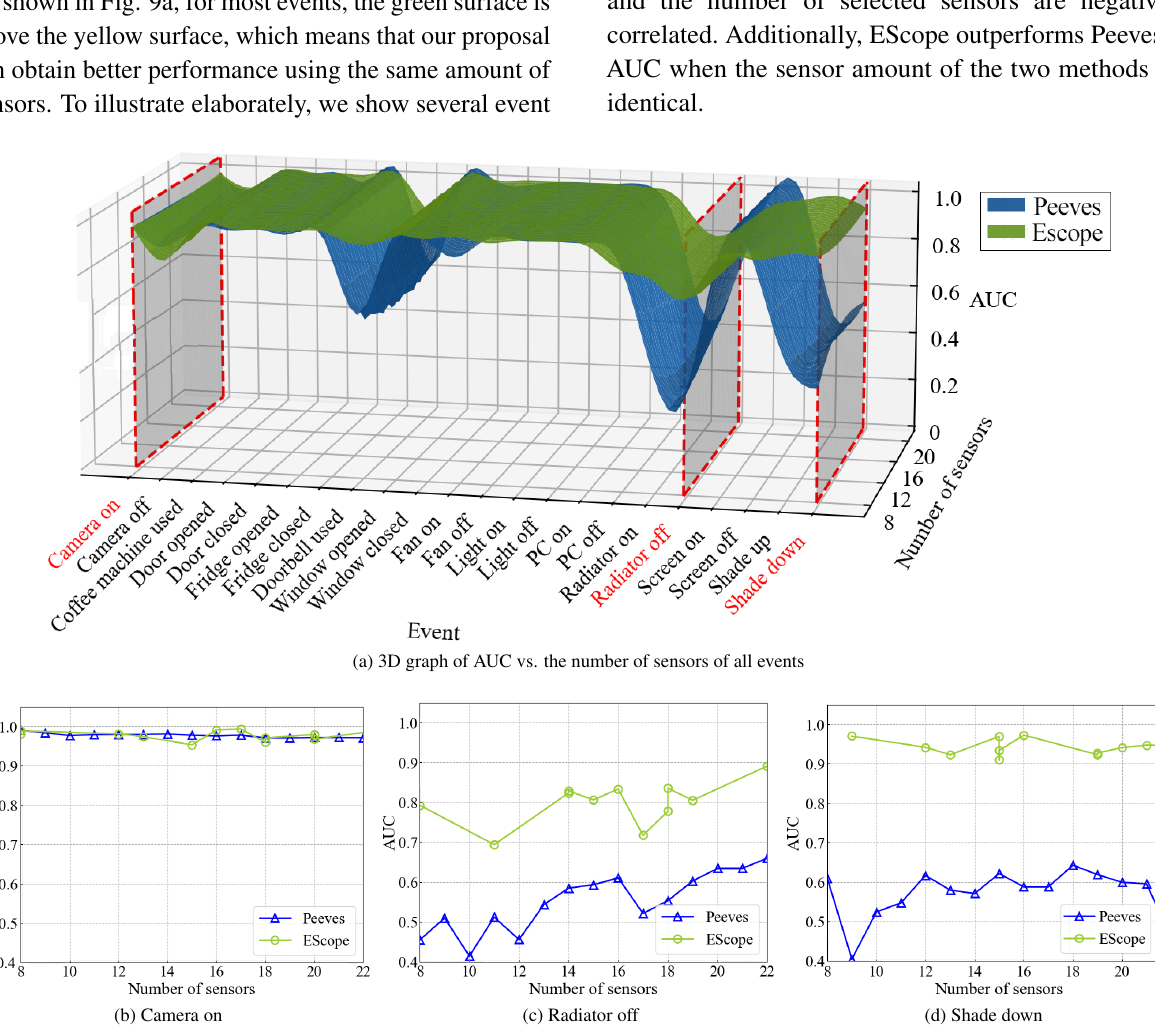
Fig. 9 Relationship between AUC and number of